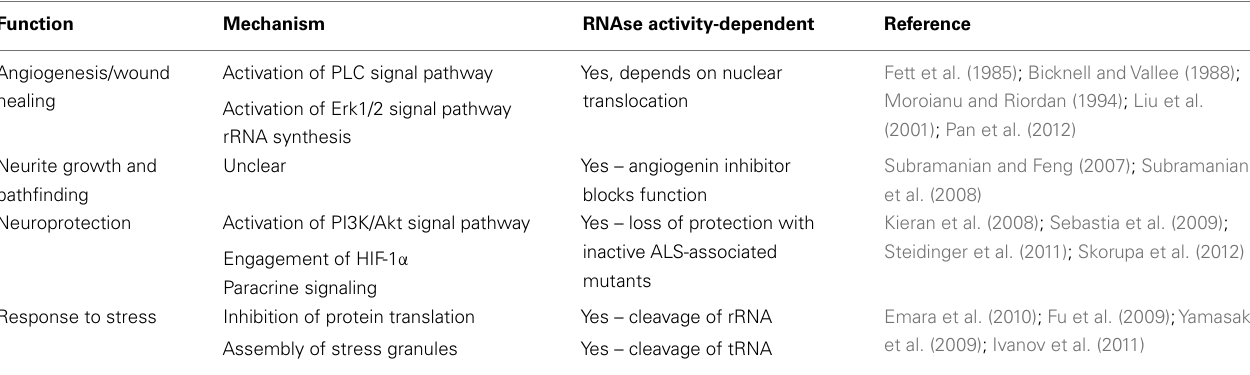
Table 2 | Functions associated with